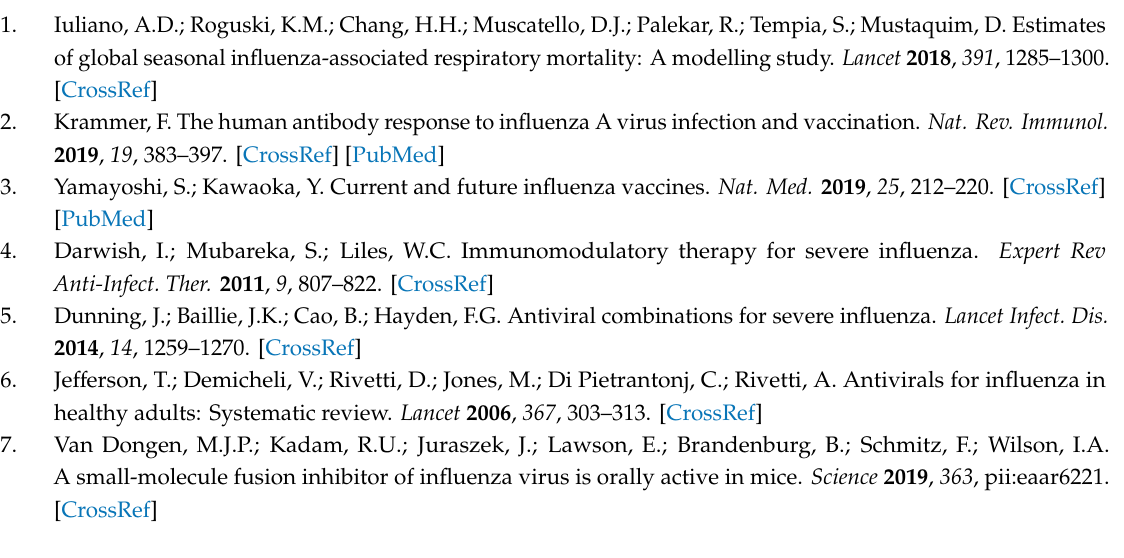
Figure S1: Antiviral e ff ects of ribavirin against influenza virus PR 8 were determined in A 549 U 937 and MDCK cells; Figure S2: Correlation analysis of the TCID 50 and neuraminidase (NA) activity of influenza virus solutions produced in cell